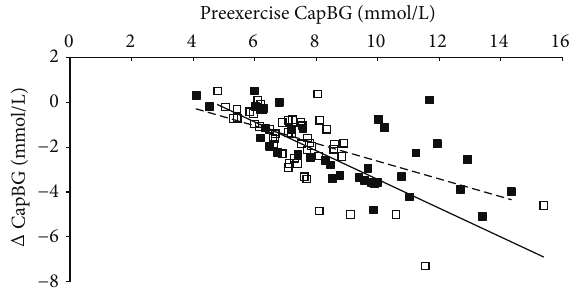
Figure 2: Correlations between preexercise CapBG and exercise- induced CapBG changes for both HI-IE and MI-CE. Filled and open squares represent MI-CE and HI-IE, respectively. Dotted and straight lines are regression lines of MI-CE and HI-IE, respectively. Glucose data obtained from each participant are categorized based on exercise intensity, duration, and modality, as well as food and medication status. Each box in the figure represents the mean glucose value obtained from each participant under different con- ditions. HI-IE: high intensity interval exercise; MI-CE: moderate intensity continuous exercise; CapBG: capillary blood